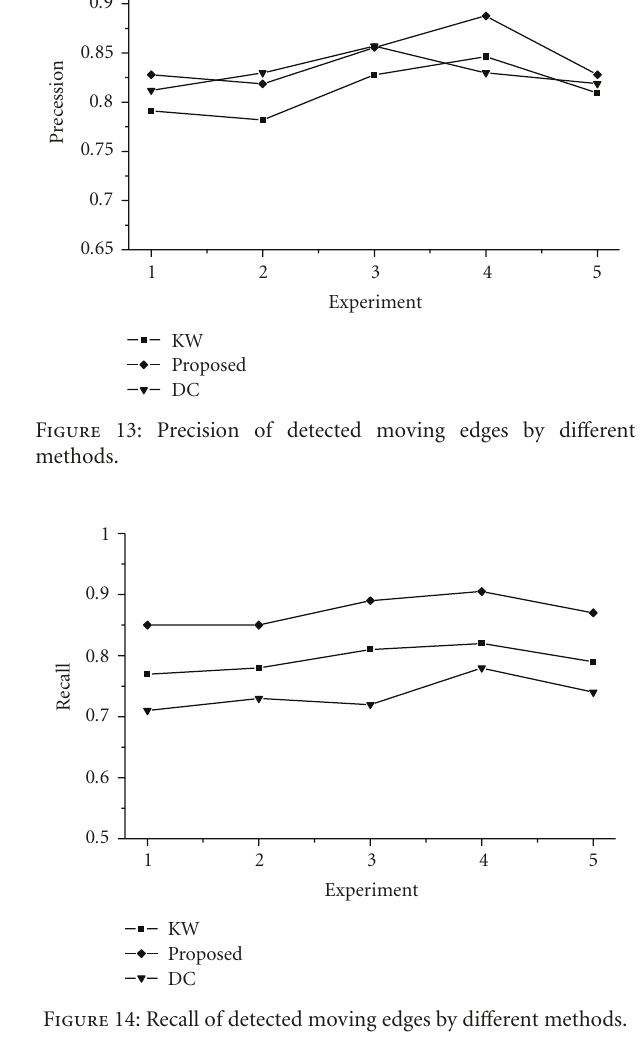
Figure 14: Recall of detected moving edges by di ff erent